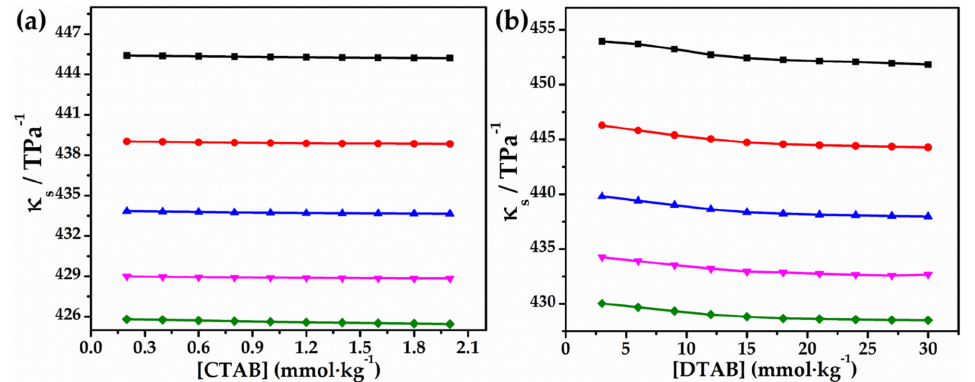
 κ Figure 2. Plots of s versus ( a ) [CTAB] and ( b ) [DTAB] in 0.010 mol∙kg –1 aqueous solution of Figure 2. Plots of s versus ( a ) [CTAB] and ( b ) [DTAB] in 0.010 mol ∙ kg –1 aqueous solution of Figure 2. Plots of κ s versus ( a ) [CTAB] and ( b ) [DTAB] in 0.010 mol · kg − 1 aqueous solution of glycyl glycyl dipeptide 293.15 K ( ■ ), 298.15 K ( ● ), 303.15 K ( ▲ ), 308.15 K ( ▼ ) and 313.15 K ( ◆ ). glycyl dipeptide 293.15 K ( ■ ), 298.15 K (●), 303.15 K ( ▲ ), 308.15 K ( ▼ ) and 313.15 K ( ◆ ). dipeptide 293.15 K ( (cid:4) ), 298.15 K ( • ), 303.15 K ( (cid:78) ), 308.15 K ( (cid:72) ) and 313.15 K ( Table 3. Apparent molar volume, ϕ V /10 − 4 (m 3 ∙ mol − 1 ) values for CTAB and DTAB in pure water and Table 3. Apparent molar volume,  V /10 −4 (m 3 ∙mol −1 ) values for CTAB and DTAB in pure water and 0.001, 0.005 and 0.010 mol∙kg −1 aqueous solution of glycyl dipeptide at different temperatures and pressure p = 100 kPa.